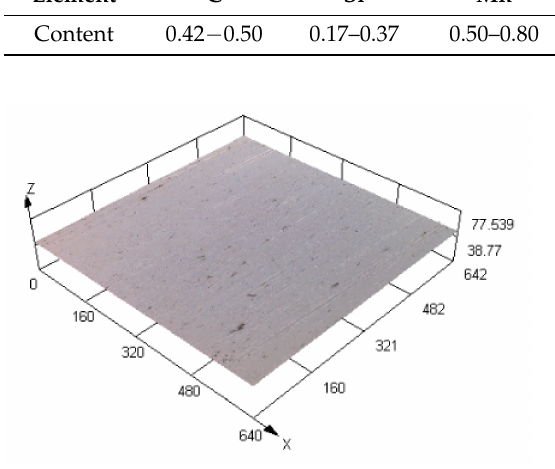
Figure 2. Three-dimensional morphology of the 45 steel.